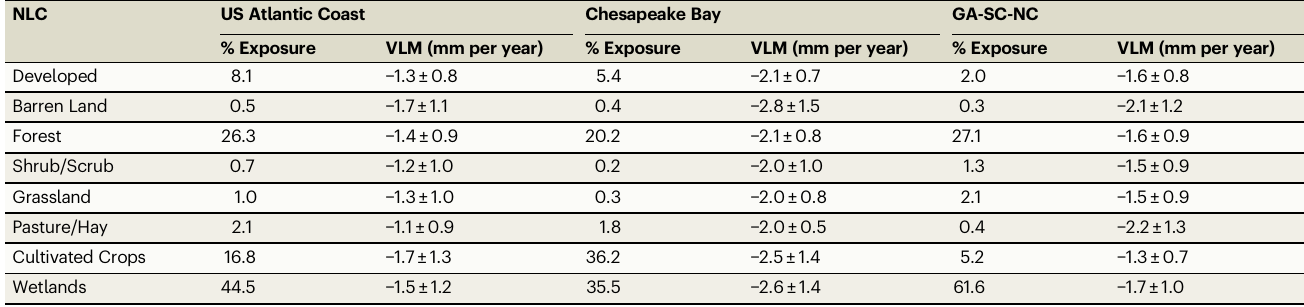
Table 1 | National land cover (NLC) exposure to land subsidence NLC US Atlantic Coast Chesapeake Bay